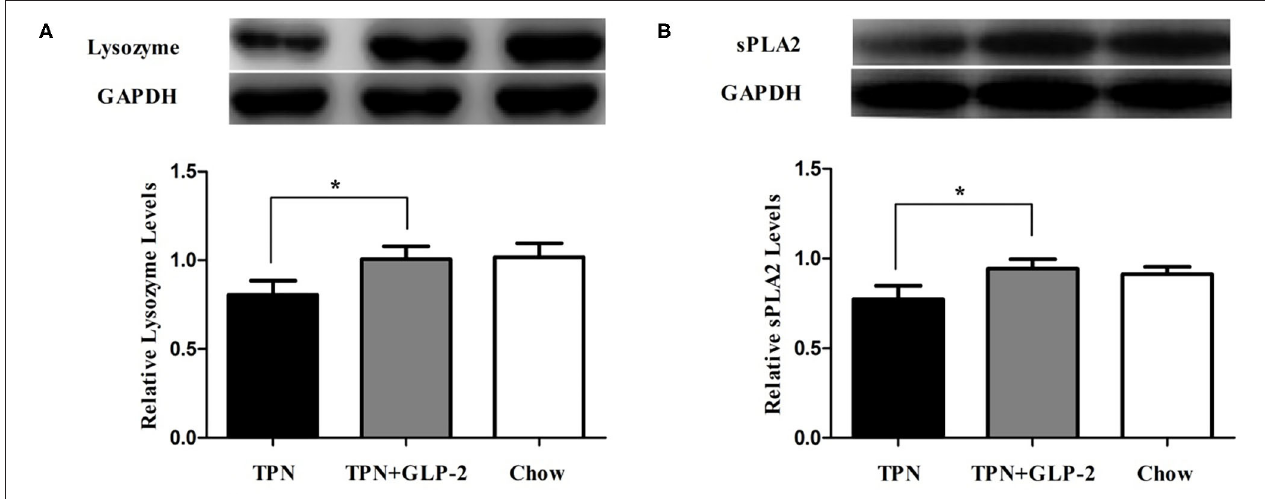
FIGURE 2 | The intestinal tissue Paneth cells function. (A) Lysozyme. (B) Secreted phospholipase A2. Where *indicates p < 0.05 for TNP vs. TPN + GLP-2 and